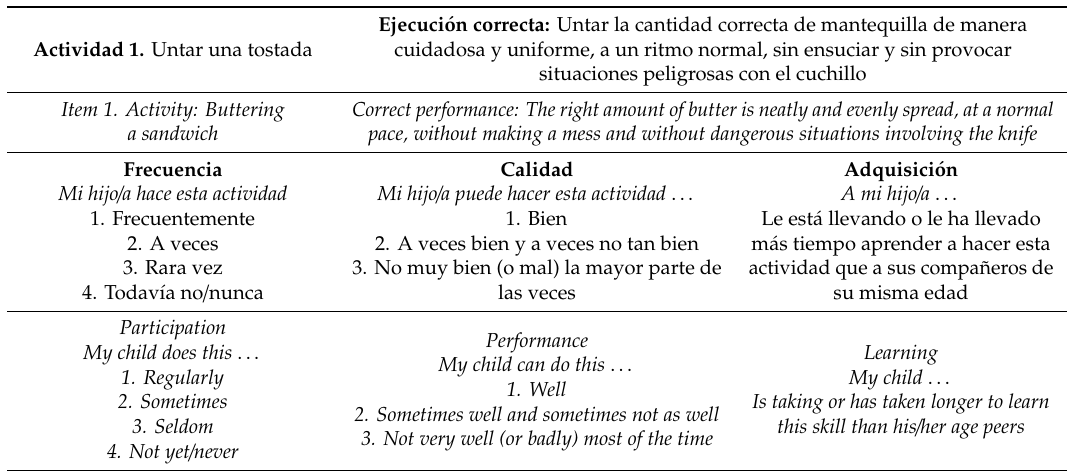
Table A2. Illustrative item of the